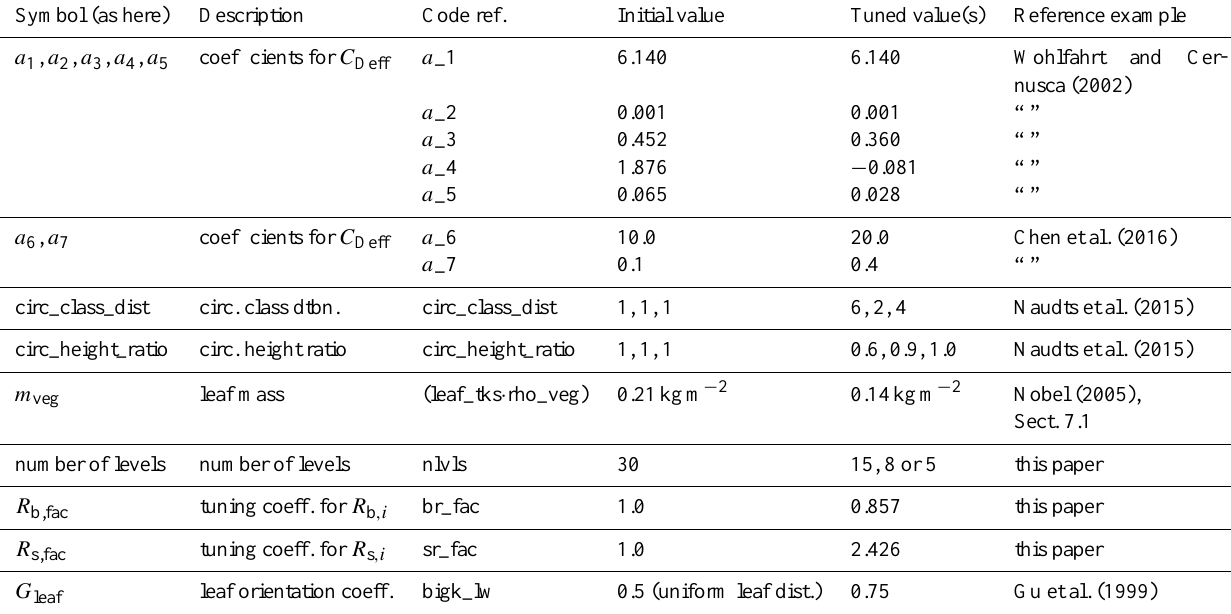
Table 3. Parameters and tuning coefficients used in the model for simulation described in this work. Symbol (as here)